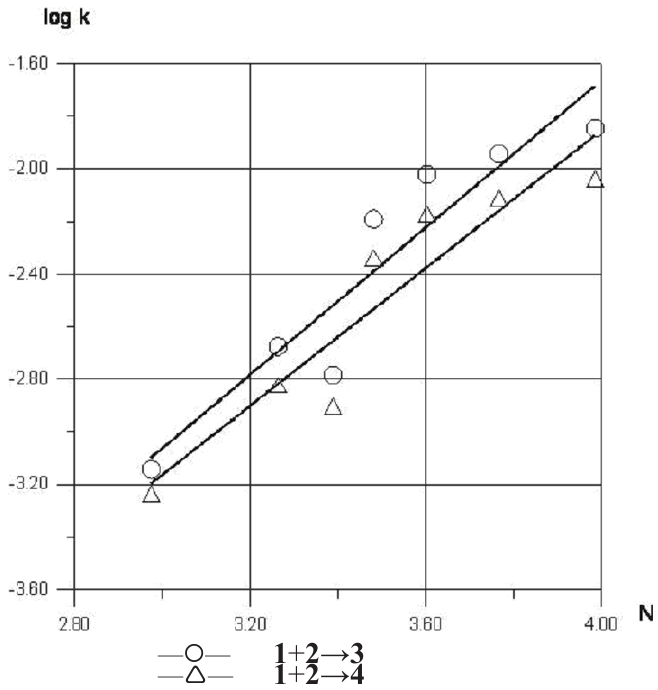
Figure 3. Plot of log k vs global nucleophilicity index Ν for [2+3] cycloaddition between 1-chloro-1nitroethene 1 and (Z)-C-aryl-N-phenylnitrones 2a-g